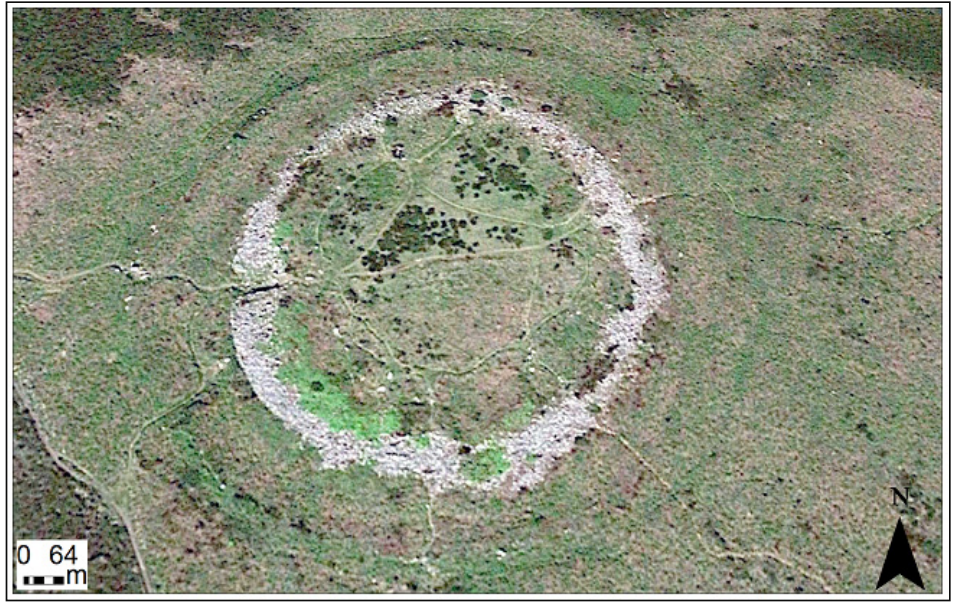
Figure 2. The reference data of the study site used to validate the assessed 3D points (Source: Image©2020 Google). Table 5. The GIS Pro confusion matrix; rows represent predicted classes, while columns represent actual